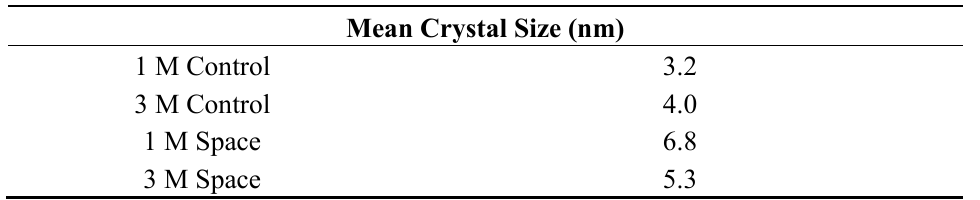
Table 2. Mean crystal sizes of CeO 2